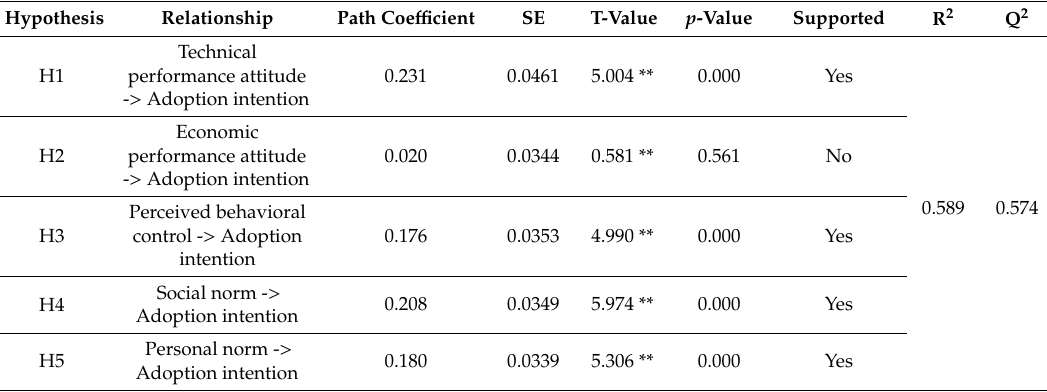
Table 7. Assessment results of the structure